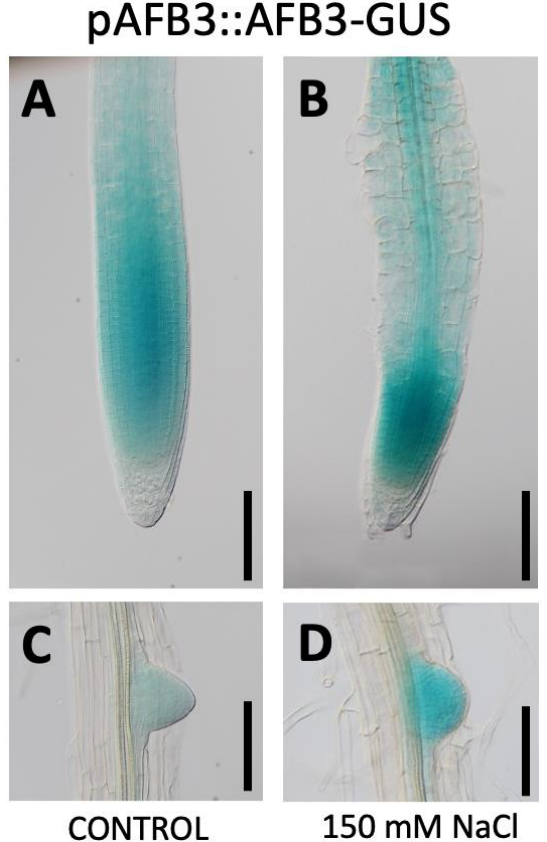
Figure 1. Salinity induces AFB3 protein expression in root meristem of Arabidopsis thaliana seedlings. Three-day-old pAFB3::AFB3-GUS ( A – D ) seedlings were transferred onto Murashige & Skoog